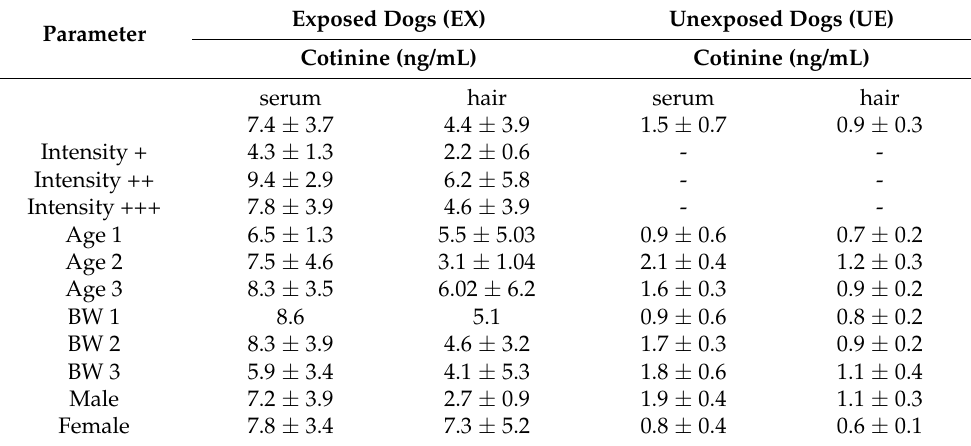
Table 2. Cotinine